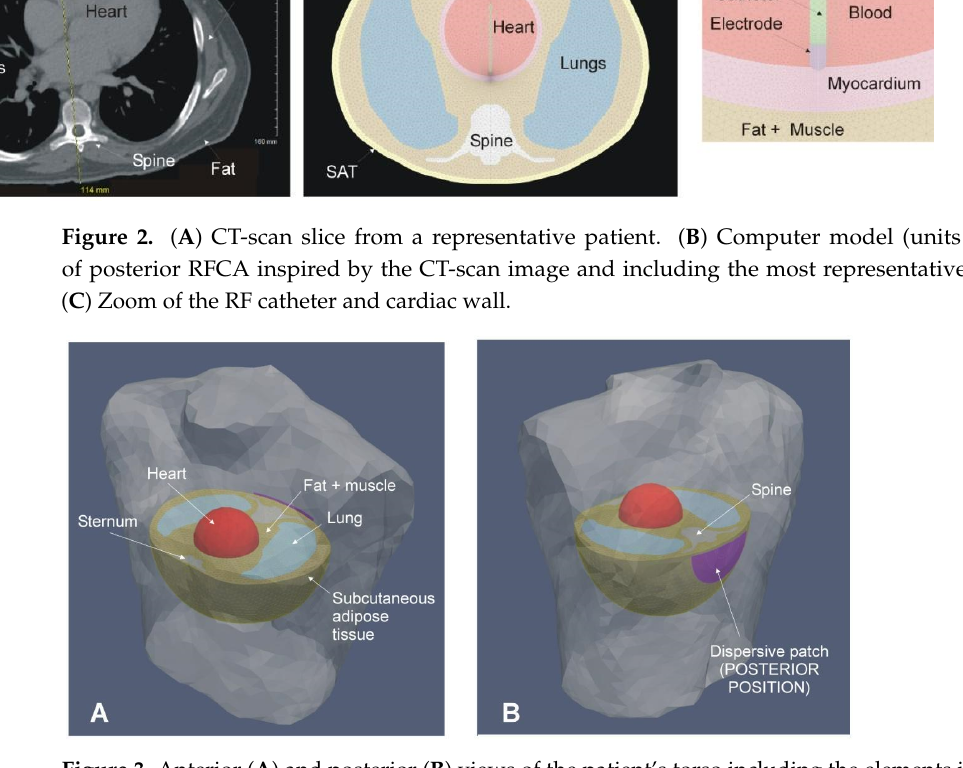
Figure 3. Anterior ( A ) and posterior ( B ) views of the patient’s torso including the elements included in the computational model. Table 1. Thermal and electrical characteristics of the elements employed in the model